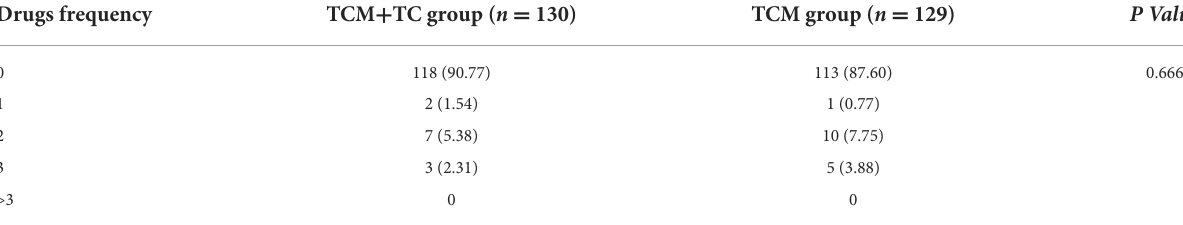
TABLE 4 Drugs frequency of rescue medication.